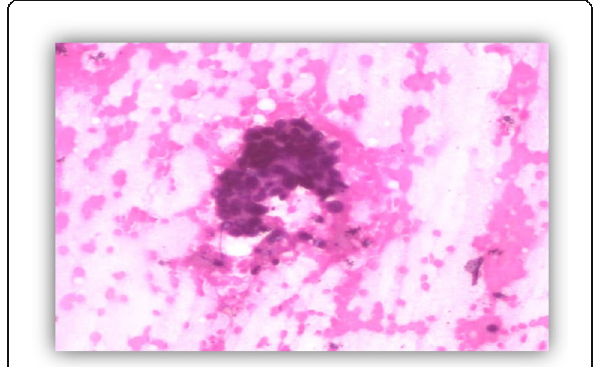
Fig. 2 Imprint cytology for bronchogenic adenocarcinoma